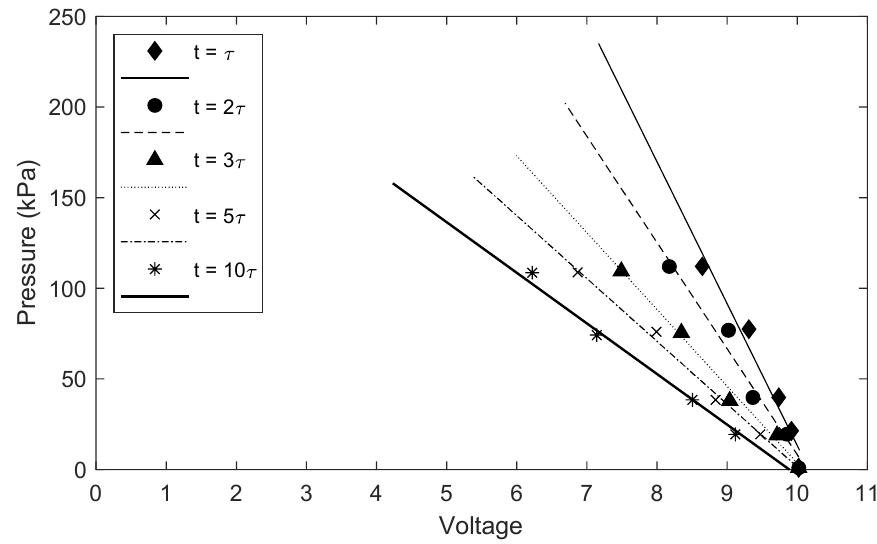
Figure 3. The calibration curves for the normal load of 3.9 N.